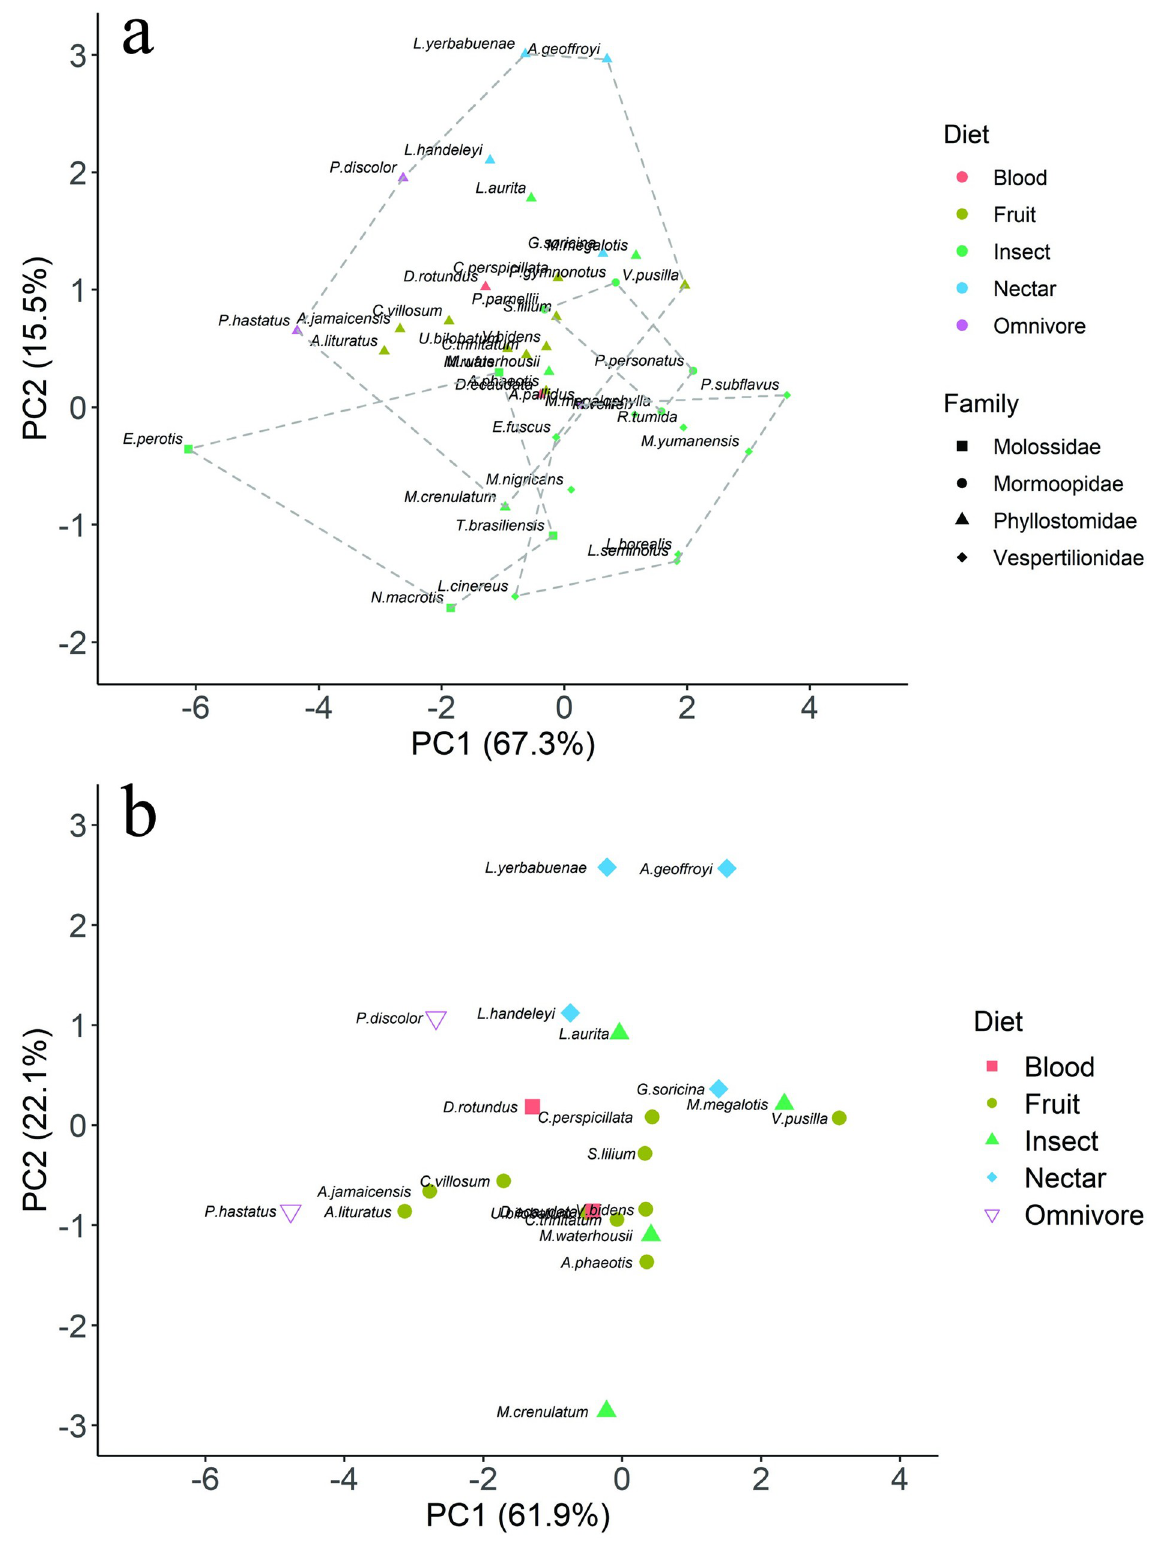
Fig 5. Ordinations of the first and second components of the phylogenetic principal component analysis (pPCA). pPCA results for the full dataset ( a ) and just Phyllostomidae ( b ). Dotted lines for the full dataset delineate minimum convex hulls for each family.